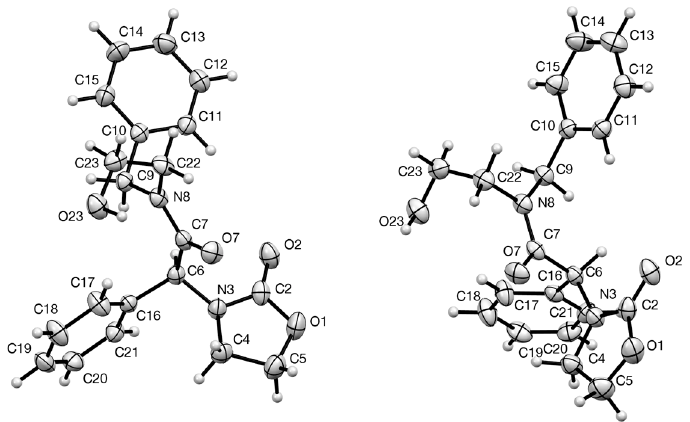
Figure 1. Two alternative views of the molecular structure of 4 (50% probability ellipsoids).